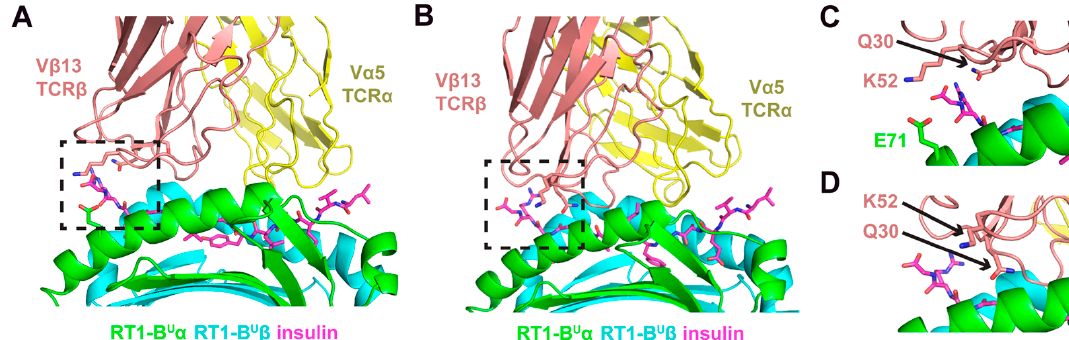
Figure 4. Two models of the putative recognition between the TCR and insulin peptide ‐ MHC. ( A ) Model A shows the TCR with a canonical diagonal binding mode over the peptide, with a calculated crossing angle of 29° and limited tilt (4.8°), and the V β 13 domain positioned over the C ‐ terminal half of the peptide, which, as in Figure 3, is on the left. ( B ) Model B exhibits an alternative TCR engagement mode of peptide ‐ MHC. For that model, a more tilted docking orientation (calculated tilt angle 16.5°) that leads to a greater engagement of the peptide MHC by the V β chain relative to the V α chain. ( C ) A close ‐ up view of the interface in Model A (boxed region in panel ( A )) shows two V β 13 CDR1 and CDR2 loop residues with identities specific to the V β 13a allele (Q30 and K52) that are positioned to readily interact with the peptide ‐ MHC. ( D ) A close ‐ up view of the interface in Model B (boxed region in panel ( B )) indicates that residue Q30 is likely to interact with the peptide ‐ MHC, whereas K52 is not predicted to contact the peptide or MHC in that model. In all panels, peptide residues are shown in magenta with stick representation, and V β 13 residues Q30 and K52 are shown in stick representation. MHC α chain residue E71, which is proximal to TCR β residue Κ 52, is shown in stick representation in panels ( A ) and ( C ). Close ‐ up views in ( C ) and ( D ) are rotated slightly with respect to panels ( A ) and ( B ), to more clearly distinguish key residues.